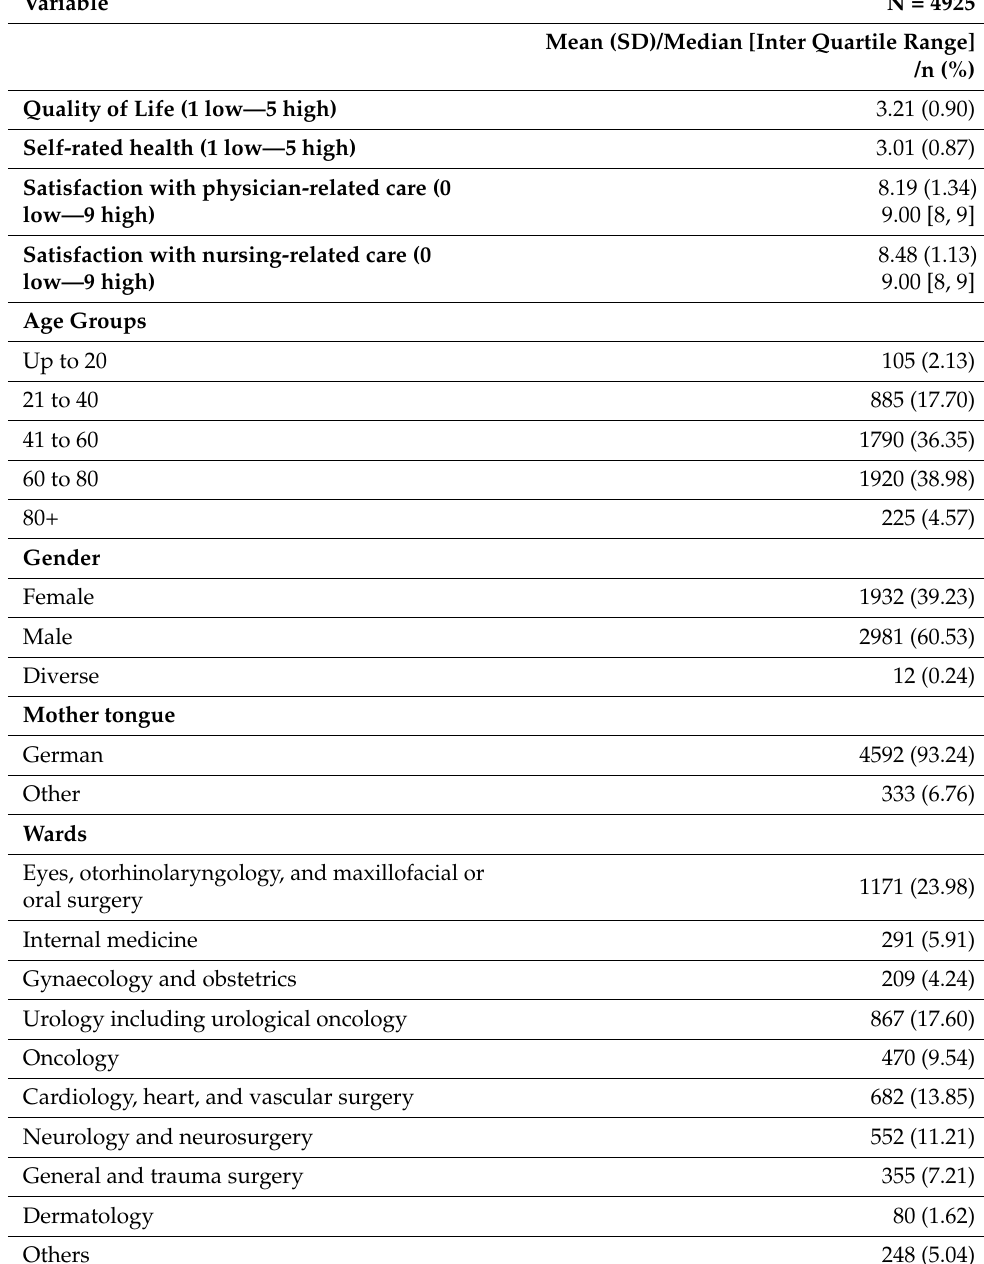
Table 1. Overview of the characteristics of the included